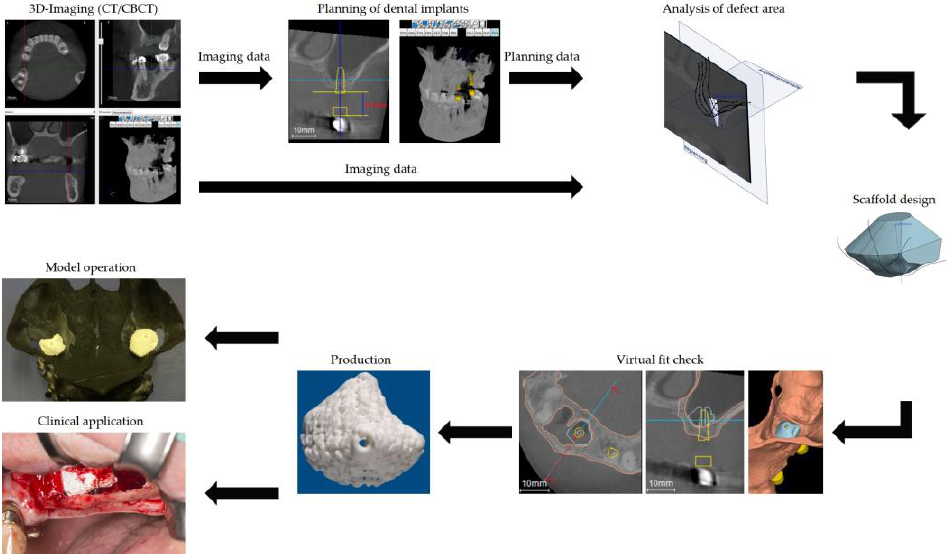
Figure 1. Schematic overview of the workflow in clockwise direction starting top left. Acquisition of the three-dimensional radiographic data (upper left). Planning of the position of the dental implants with yellow contour indicating the planned implant and the corresponding sleeve (upper center). Analysis of the defect size and topography (upper right). Virtual design of the scaffold (center right). Virtual check of the designed scaffold with yellow contour indicating the planned implant and the corresponding sleeve, light blue contour indicating the planned scaffold and brown contour indicating the pristine bone in the transversal plane; coronary plane is indicated by the red arrows (lower right). Manufacturing of the scaffolds (lower center). Check of the designed scaffold in a three-dimensional model of the defect situation (center left). Clinical application of the scaffold in the patient (lower left).